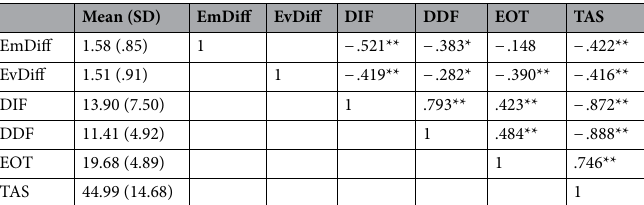
Table 1. Correlation coefficients (Spearman’s ρ) and descriptive statistics (mean and standard deviation) for all variables in Study 1. * indicates p < .05, ** indicates p <